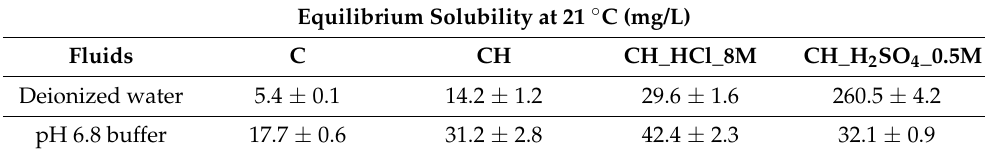
Table 6. Equilibrium solubility at room temperature of samples C, CH, CH_HCl_8M, and CH_H 2 SO 4 _0.5M.